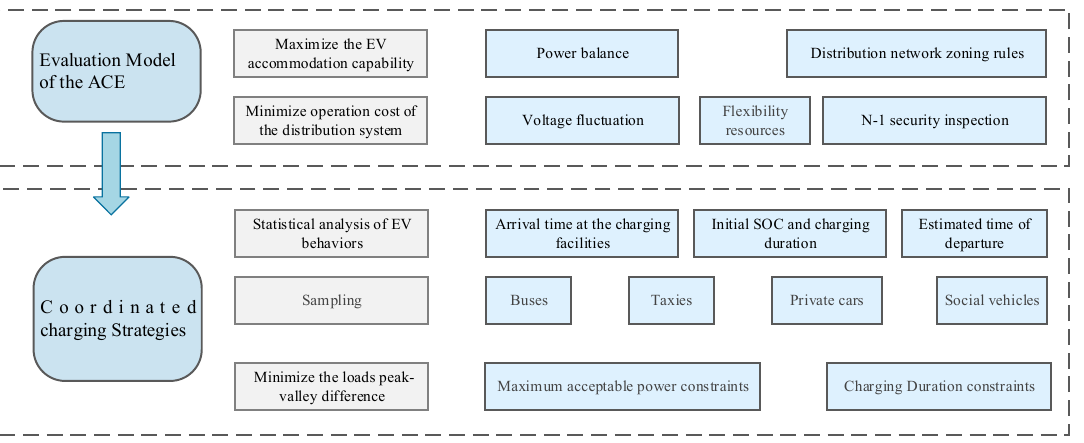
Figure 1. A schematic diagram of the model framework.